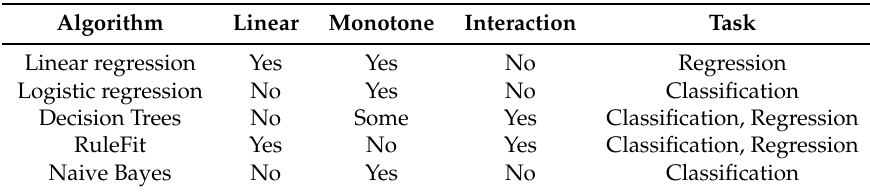
Table 3. Interpretable models